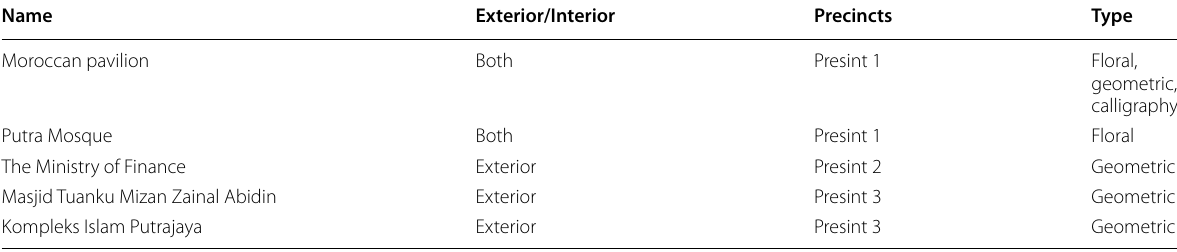
Table 1 Types of the Islamic architectural decorative